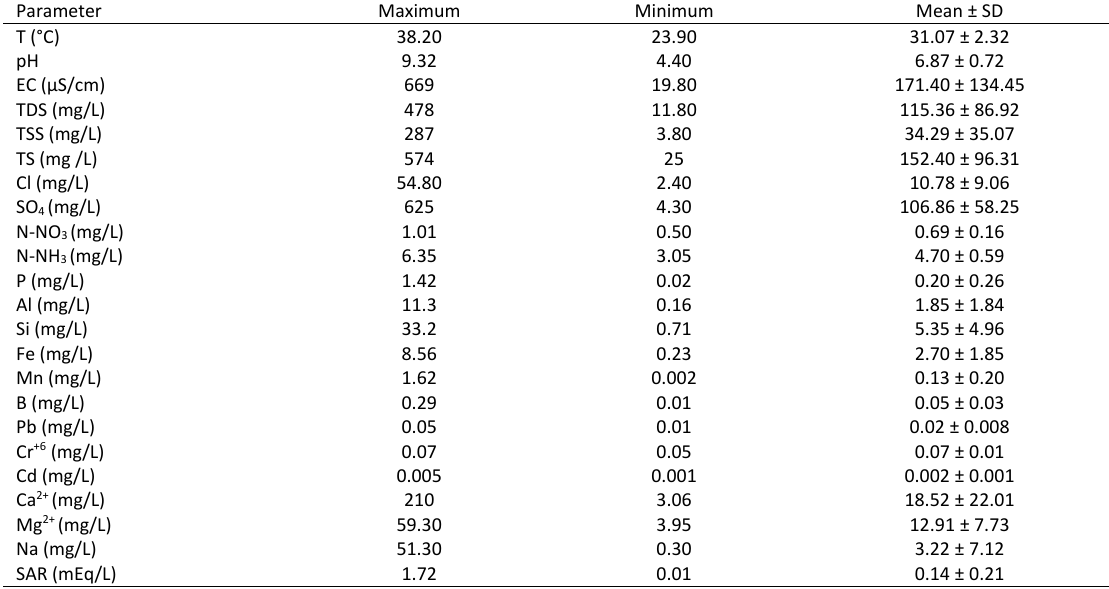
Table 2 : Results for the physicochemical parameters analyzed in water used for irrigation in the department of Sucre, in northern Colombia Parameter Maximum T (°C)